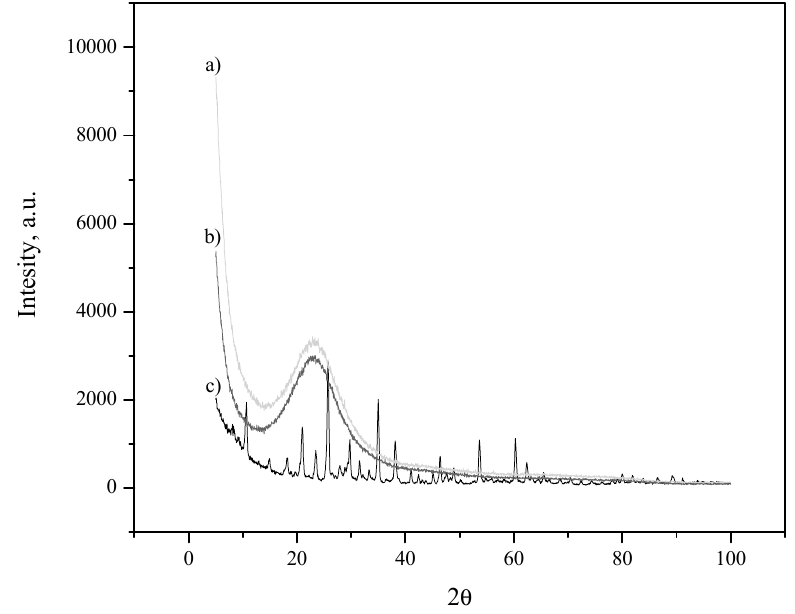
Figure 1. XRD patterns of the fillers ( a ) SBA-15, ( b ) PWA / SBA-15, ( c ) PWA.